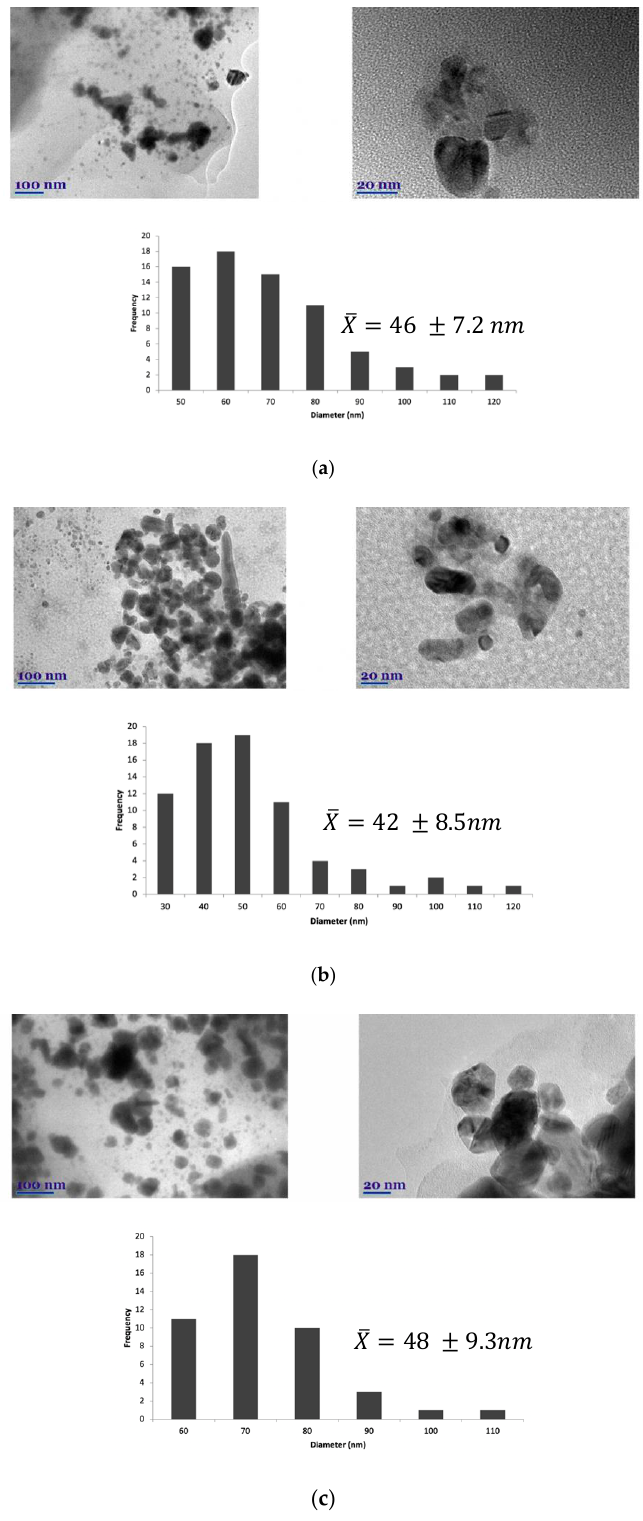
Figure 5. TEM micrographs and size distribution of AgNPs obtained using A. absinthium ( a ), H. lupu- lus ( b ), and T. vulgaris ( c )